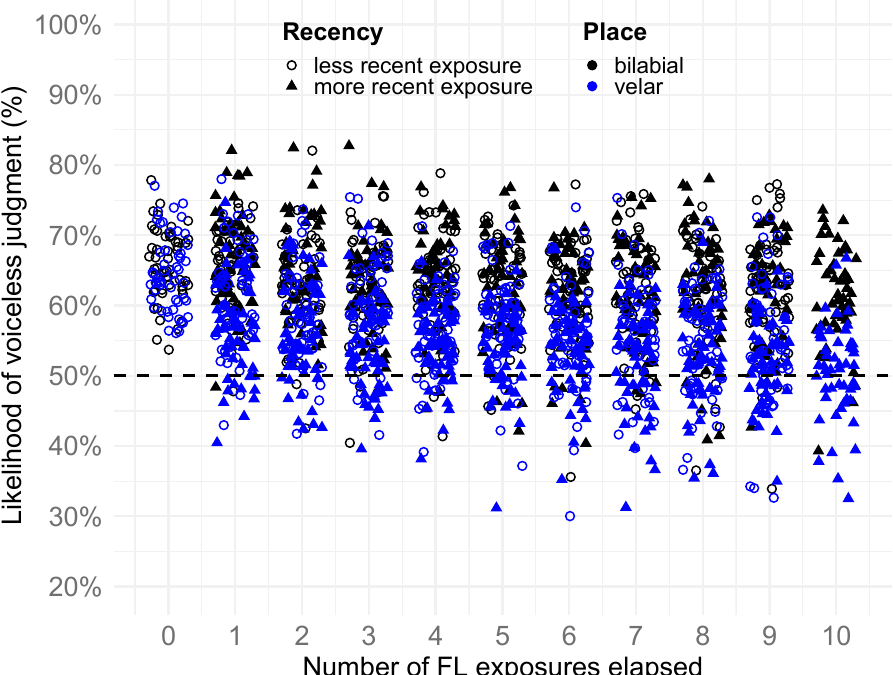
Figure 8. Likelihood of voiceless identification in the FL exposure task conditions, by number of FL exposures, recency of last FL exposure, and place of articulation of the plosive continua. Points (jittered) represent individual participants, averaging over the three plosive continua for the given place of articulation. The dashed line represents the chance value for the binary judgment. By-condition means are plotted in Figure 9, which shows that the trend for voiceless judgments to become less likely with more exposures is evident in all task conditions, including the control condition (where the exposures were to non-linguistic sounds). However, compared to the control condition, the slope of the decrease is generally steeper in the FL exposure task conditions (conditions 1–3), particularly after exposure 3; this was true of both variants of condition 3 (3a and 3b), which did not noticeably differ from each other and were therefore combined in all visualizations and modeling.